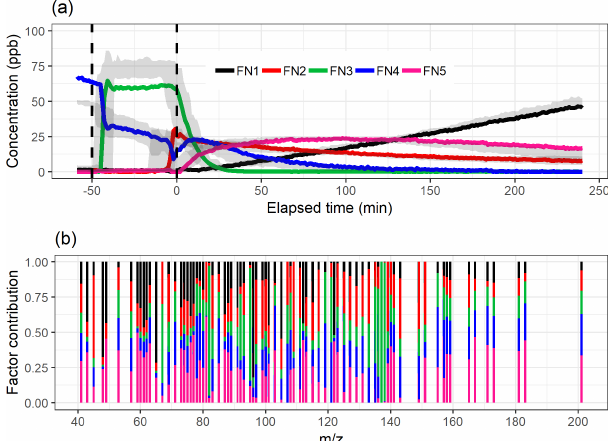
Figure 6. The time series (a) of the factors and the distribution of ion to factor (b) from NMF with five-factor solution. Shaded areas in the time series indicate the factor range for the bootstrap resam- ples; solid lines are for the measured gas-phase (PTR-MS) data. The colour code identifying clusters is the same in both panels. Factors were identified as later-forming and slowly forming products (FN1), early products (FN2), α -pinene precursor (FN3), background or car exhaust precursor (FN4), and intermediate products